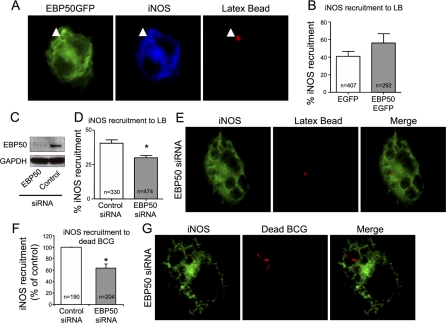
EBP50 Controls iNOS Localization Relative to Phagosomes(A and B) Macrophages were transfected with EBP50-GFP, stimulated with IFN-γ and LPS for 16 h, and then allowed to phagocytose Texas Red–labeled latex beads for 10 min. After 1-h chase, cells were fixed, stained for iNOS, and examined by confocal microscopy.(A) Confocal microscopy images showing localization (triangle) of EBP50-GFP (green) and iNOS (blue) to latex bead phagosomes (red).(B) Quantification of iNOS localization to latex bead phagosomes. Bars, mean ± s.e.m. (three independent experiments); n, number of phagosomes counted per condition.(C–E) Macrophages were transfected with either control (scramble) or EBP50 siRNA, stimulated with IFN-γ and LPS for 16 h, and then allowed to phagocytose Texas Red–labeled latex beads for 10 min. After 1-h chase, cells were fixed, stained for iNOS, and examined by confocal microscopy.(C) Western blot of EBP50 and loading control (GAPDH) after 48 h (includes IFN-γ and LPS stimulation).(D) Quantification of iNOS recruitment to latex bead phagosomes. Bars, mean ± s.e.m. (three independent experiments); n, number of phagosomes counted per condition. *
p = 0.0254.(E) Absence of iNOS localization (green) to latex bead phagosomes (red).(F and G) Macrophages were transfected with either control (scramble) or EBP50 siRNA, stimulated with IFN-γ and LPS for 16 h, and then allowed to phagocytose Alexa 568–labeled dead mycobacteria for 10 min. After 1-h chase, cells were fixed, stained for iNOS, and examined by confocal microscopy.(F) Quantification of iNOS recruitment to dead mycobacteria phagosomes. The results are represented as percent relative to control siRNA. Bars, mean ± s.e.m. (three independent experiments); n, number of phagosomes counted per condition. *p = 0.049.(G) Absence of iNOS localization (green) to dead mycobacteria phagosomes (red).